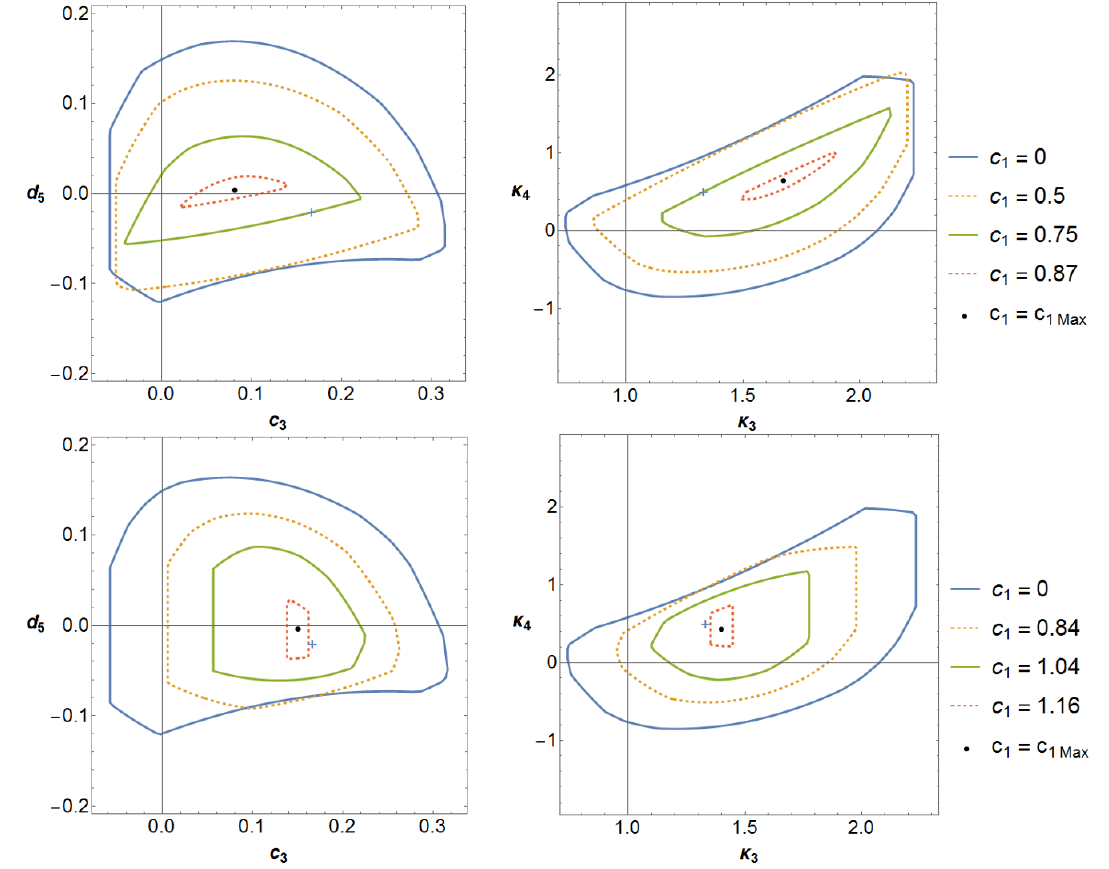
Figure 2 . The allowed region of parameters obtained from the inde(cid:12)nite hh ! hh scattering for di(cid:11)erent values of c 1 at x = m 1 =m 2 = 0 : 5 (up) and x = 2 (down). The results are presented in both ( c 3 ; d 5 ) plane (left) and ( (cid:20) 3 ; (cid:20) 4 ) plane (right). By increasing c 1 the island shrinks until it becomes a point at c 1 = c 1max shown by the black dot. For x = 0 : 5 this point is reached at c 1max = 0 : 9, and for x = 2 at c 1max = 1 : 2. The cross in all (cid:12)gures represents the minimal model with c 3 = 1 = 6 and d 5 = (cid:0) 1 = 48, or (cid:20) 3 = 4 = 3, (cid:20) 4 = 1 =